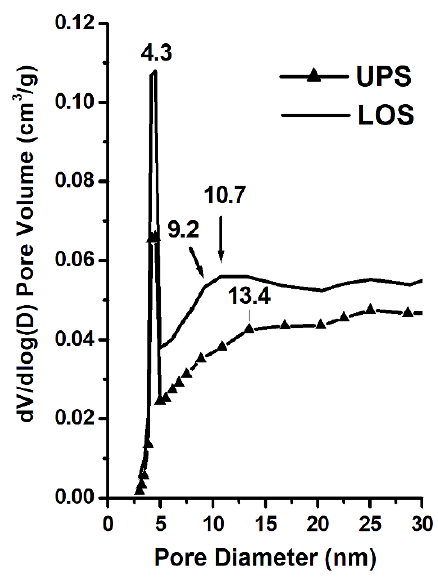
Figure 11. BJH pore size distribution of the halloysite in the UPS and LOS samples.